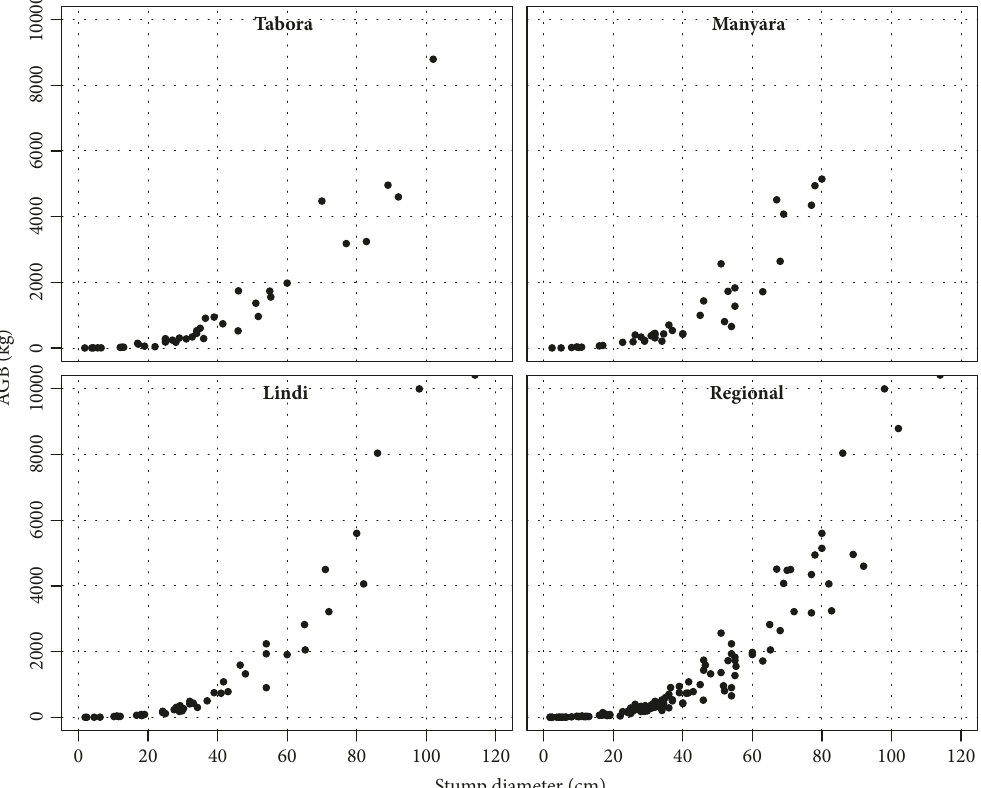
Figure 5: Scatter plots of sample trees aboveground biomass distribution versus stump diameter for the three sites and for all sites combined.